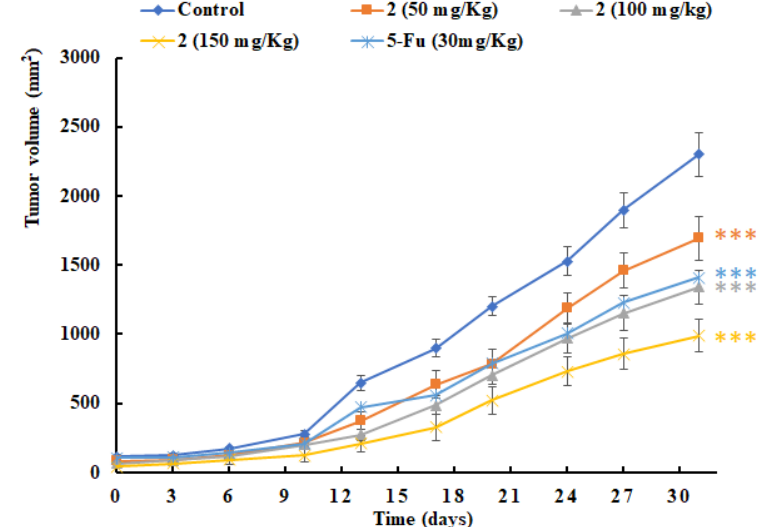
Figure 2. The efficacy study of 2 . In vivo antitumor activity of compound 2 was evaluated in HCT-116 tumor xenograft bearing nude mice. Compound 2 (50, 100, or 150 mg / kg, p.o.) was administered once daily and 5-Fluorouracil was administrated (30 mg / kg, i.p.) every other day. The results are the mean ± SEM of six mice in each group. *** P < 0.001 compared to untreated control.